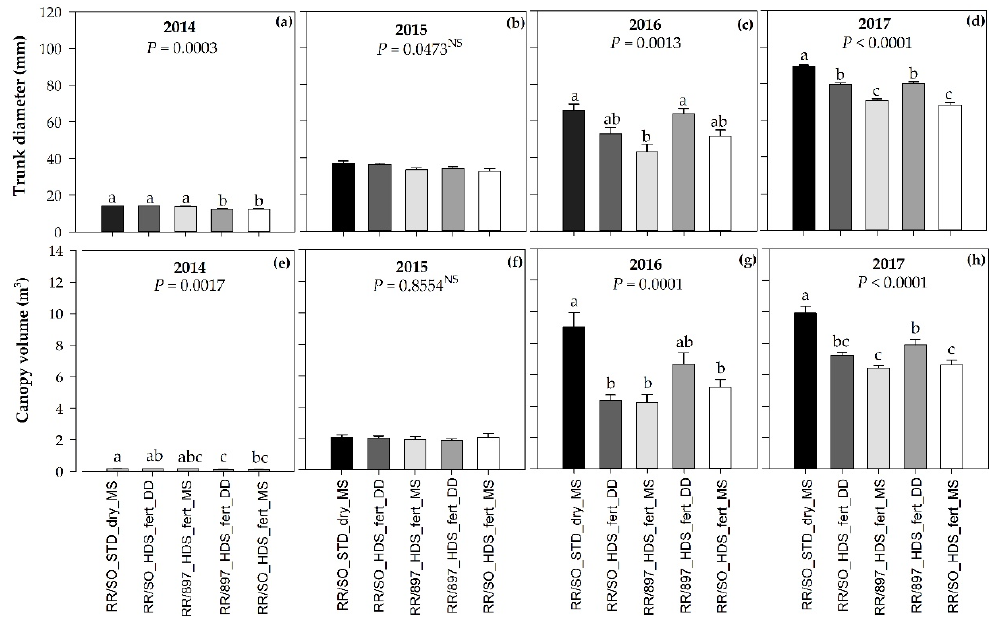
Figure 3. Trunk diameter ( a – d ) and canopy volume ( e – h ) of “Ray Ruby” grapefruit (RR) trees.